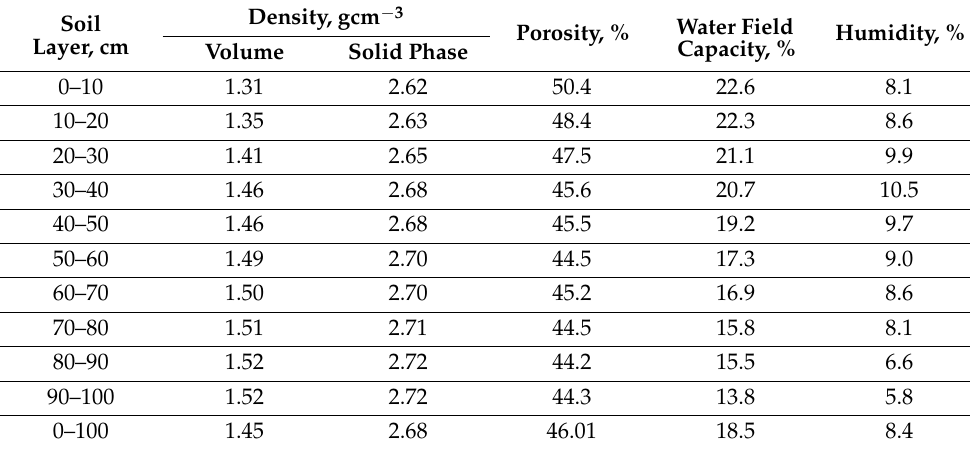
Table 3. Water and geophysical properties (in example of the Endosalic